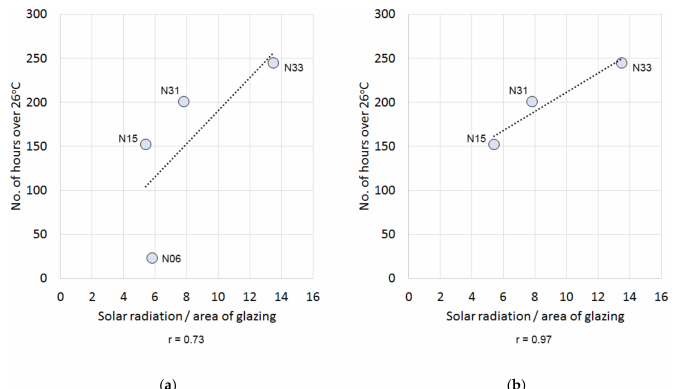
Figure 10. High temperature hours vs. solar radiation per area of glazing: ( a ) Flats N31, N33, N15, N06; ( b ) Flats N31, N33, N15.